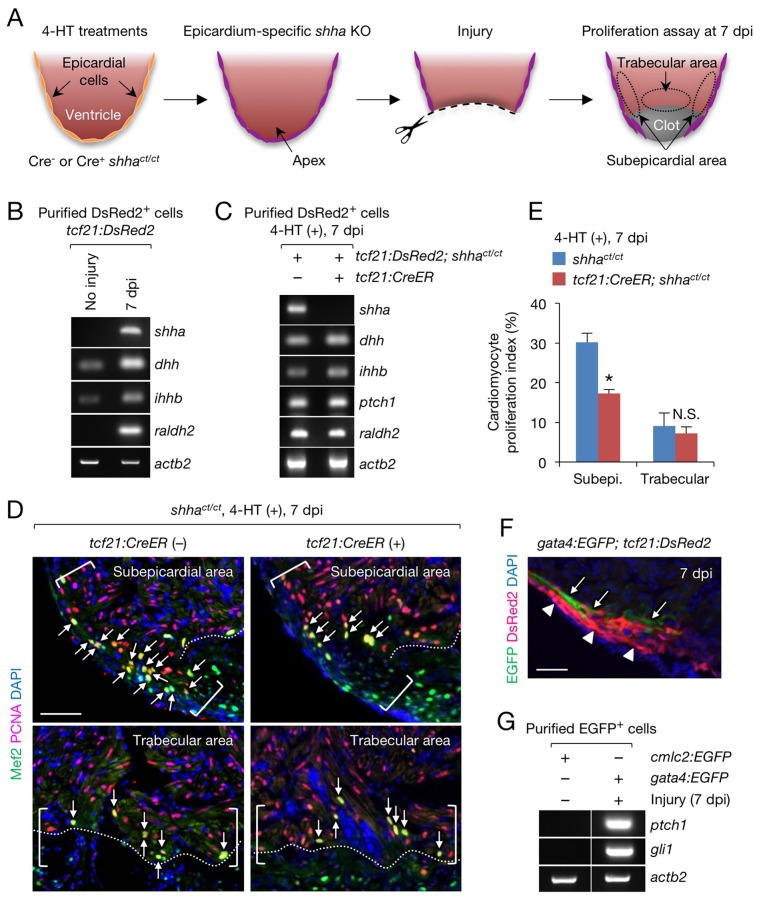
Epicardial shha expression promotes subepicardial cardiomyocyte proliferation during heart regeneration.(A) Schematic of the experiment. (B) Semi-qRT-PCR analysis of shha in purified tcf21:DsRed2+ epicardial cells obtained from uninjured and injured (7 dpi) tcf21:DsRed hearts. Injury was confirmed by the induction of raldh2 expression. (C) Semi-qRT-PCR analysis of Hh pathway genes using purified tcf21:DsRed2+ epicardial cells obtained from 4-HT–treated 7 dpi tcf21:DsRed; shhact/ct (control, left) and tcf21:DsRed; tcf21:CreER; shhact/ct hearts (right). (D) Immunofluorescence images of the subepicardial (top) and trabecular areas (bottom) of heart sections obtained from 4-HT–treated 7 dpi shhact/ct (control) or tcf21:CreER; shhact/ct hearts. Brackets, subepicardial areas. Dotted lines, approximate amputation plane. Arrows indicate proliferating cardiomyocytes. (E) Quantification of cardiomyocyte proliferation in the subepicardial and trabecular areas of the heart sections obtained from 4-HT–treated 7 dpi shhact/ct (control) or tcf21:CreER; shhact/ct hearts shown in D (n = 6 each). The data are presented as the mean ± SEM (**p<0.01, Mann–Whitney U test). N.S., not significant (p=0.3367). (F) Image of heart sections obtained from 7 dpi gata4:EGFP; tcf21;DsRed2 fish. Subepicardial cardiomyocytes (green, arrows) associate with epicardial cells (magenta, arrowheads). (G) Semi-qRT-PCR analysis of shha pathway genes using purified subepicardial cardiomyocytes obtained from 7 dpi gata4:EGFP ventricles. Cardiomyocytes purified from uninjured cmlc2:EGFP ventricles were used as negative controls. Scale bar, 50 μm.